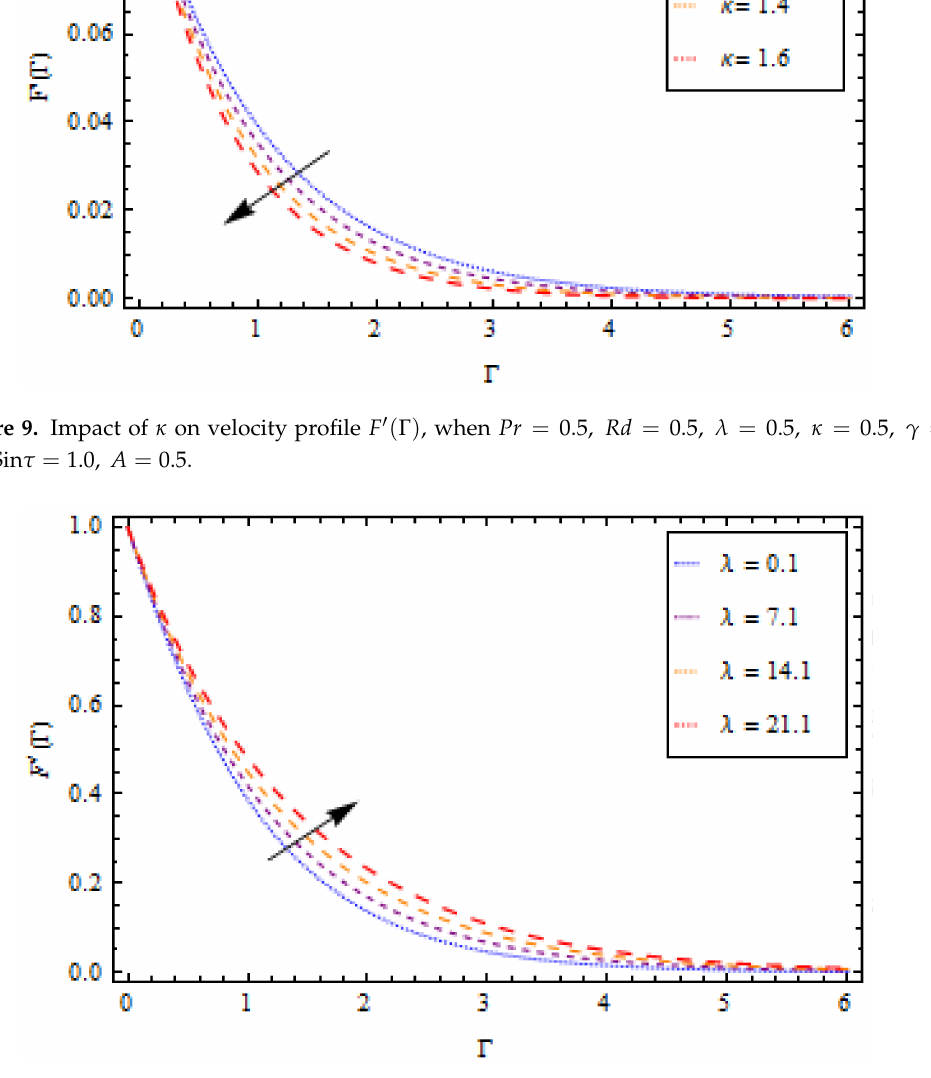
Figure 10. Impact of λ on velocity profile F (cid:48) ( Γ ) when Pr = 0.5, Rd = 0.5, K = 0.5, κ = 0.5, γ = 0.5, Sin τ = 1.0, A =